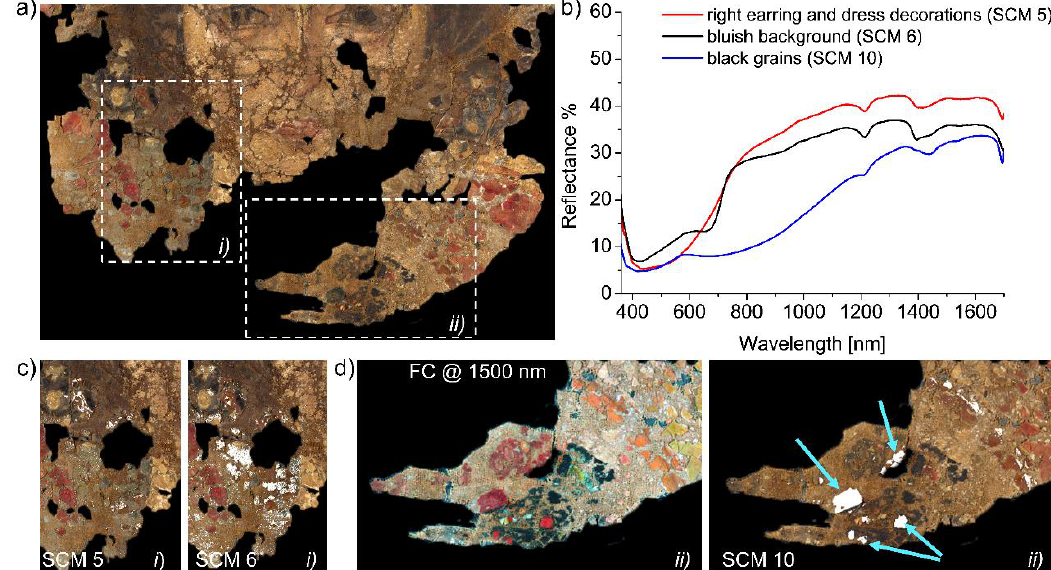
Figure 5. Spectral analysis decoration areas identified by SCM 5, 6, and 10: ( a ) RGB image highlighting the relevant regions i and ii , magnified in ( c , d ); ( b ) FORS spectra of endmembers 5, 6, and 10; ( c ) Comparison of SCM 5 and 6 in region i . ( d ) Region ii in the FC image and SCM 10 showing the black grains, pointed out by the light blue arrows. Spectral mapping of the brown areas (see Figure S2 in the Supplementary Material) shows two partially overlapping distributions (SCM 2 and 3), both covering the hair area, whereas only one of them (SCM 2) includes the eyes and the dress collar. The correspond- ing FORS spectra showed similar behaviour for both distributions, namely low intensity reflectance values over the entire acquisition range, which can be attributed to the pres- ence of charcoal black. The main difference between the two spectra was the presence of an inflection point at 550 nm, visible only in SCM 2, which is consistent with iron oxide pigments (possibly umber and yellow ochre [35]) mixed with other pigments. 3.2. Laser Scanning Microprofilometry The micrometric examination of the surface topography allowed for the visualization of 3D features related to the different tools used to spread the paint, namely strokes of a fine-hair brush that are visible on the red-yellow background, and sequences of grooves, observable in the woman’s skin tone, eyes, nose, and mouth. The latter marks can be easily ascribed to a small spatula, such as a heated cauterium, which is typical of the encaustic technique and has already been identified in other portraits [7,16]. The scanning of the entire surface was performed with a sampling step of 100 μm (see Figure S4 in the Sup- plementary Material for the topographic map of the entire surface). Few smaller regions, such as the sequence of well-defined grooves on the woman’s right cheekbone (Figure 7a), were measured with a 50 μm sampling step. Surface profiles were extracted from the topographic map (Figure 7b) to measure the size of the marks after the subtraction of the surface shape by spline interpolation (green line in Figure 7b). The difference in the grooves size resulted in a range of 0.5–1 mm, which is likely due to a successive applica- tion of the cauterium on the same area.